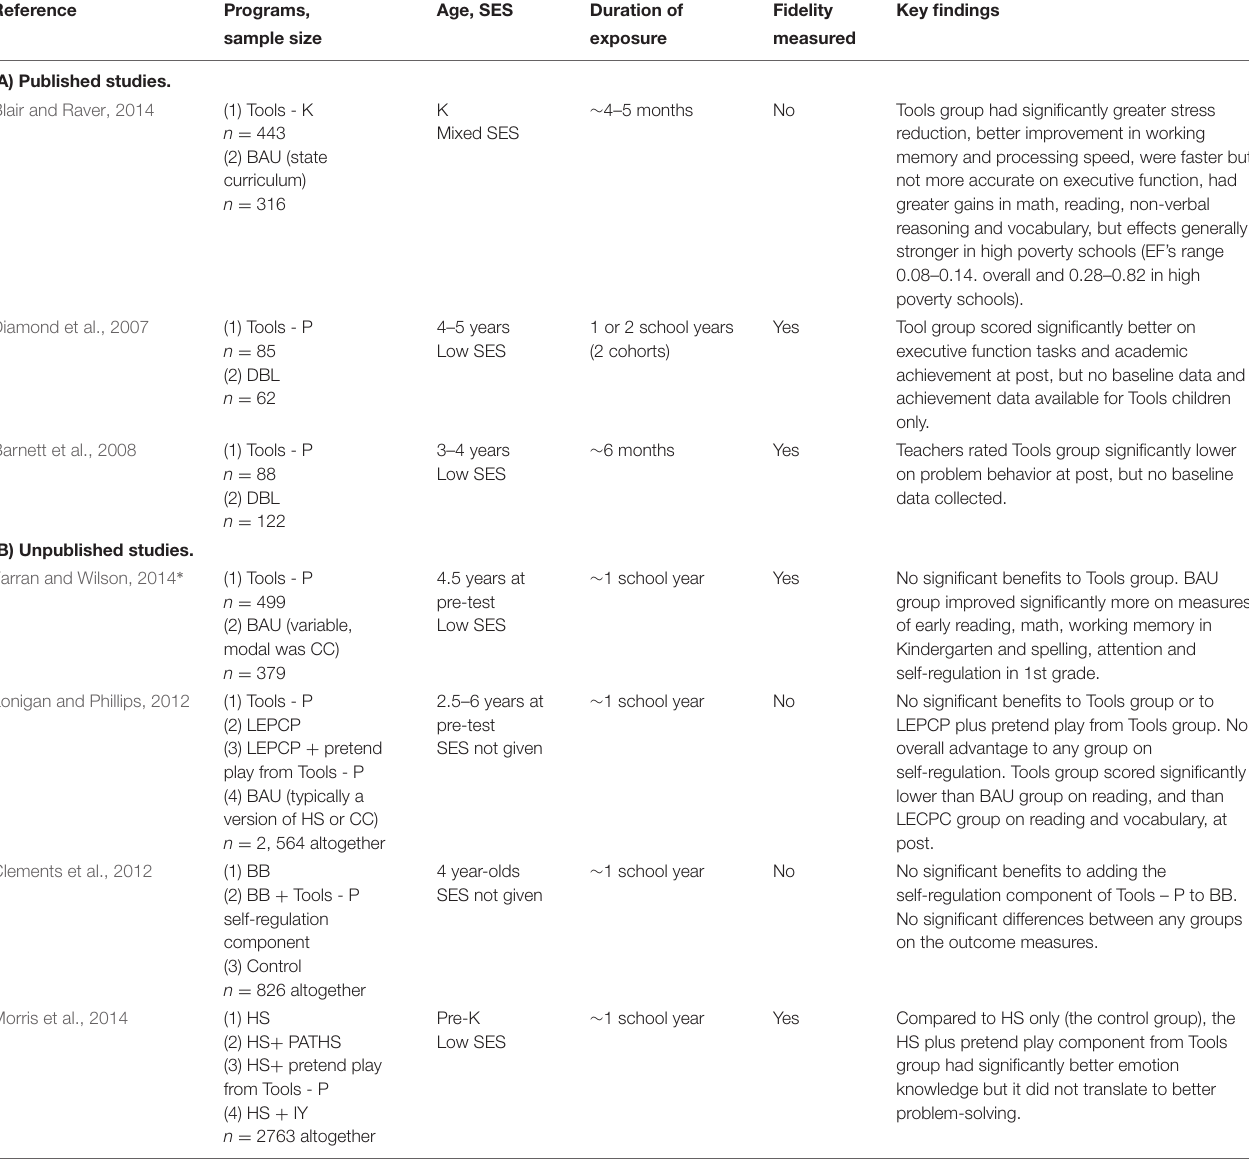
TABLE 1 | Summary of previous research on the effectiveness of the Tools preschool